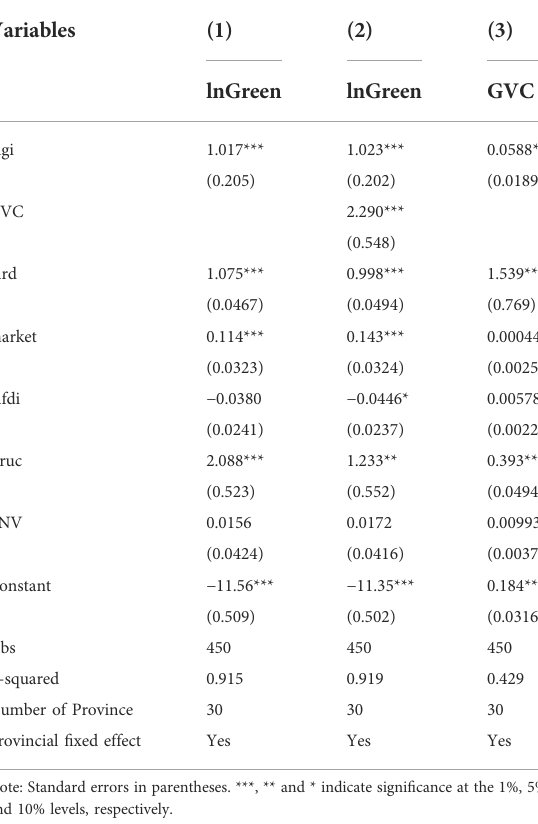
TABLE 4 Regression results of mediating effect test. TABLE 5 Global spatial autocorrelation